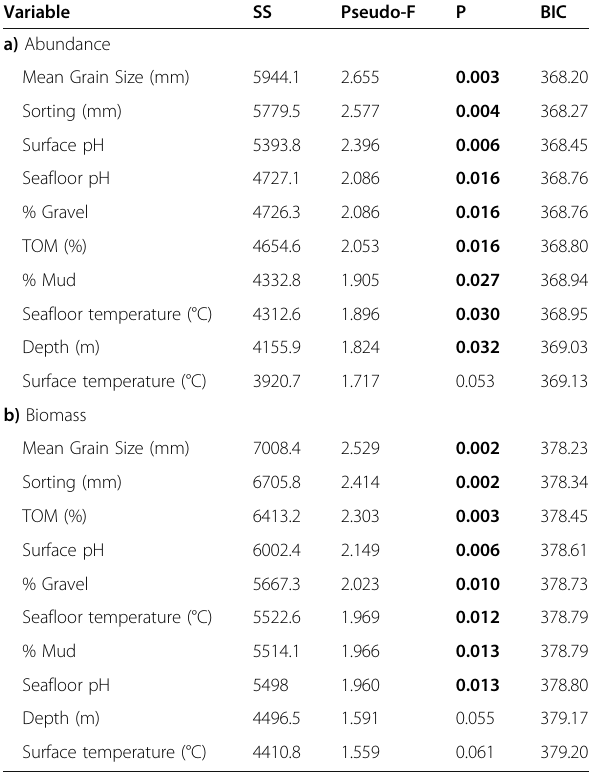
Table 5 Results of the marginal test for DISTLM analysis, using the BEST procedure for the Bray-Curtis resemblance matrix based on abundance (a) and biomass (b). Data were standardized and then fourth-root transformed. P(perm) < 0.05 values are in bold. BIC = Bayesian Information Criterion. SS = Sum of Squares. For the DISTLM analysis we used all the data described in Table 3. In what follows we only present the first 10 best environmental variables according to BIC criteria. Res.